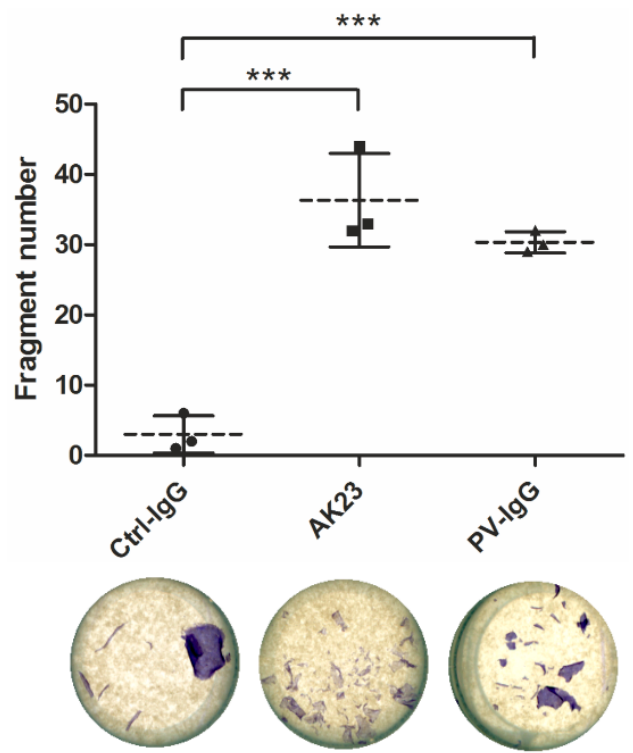
Figure 8. E ff ect of PV-IgG and anti-Dsg3 antibodies on the monolayer integrity in hTert cells. The cells were grown in KGM with 0.05 mM calcium until confluent and then shifted to 2 mM calcium for 24 h. Thereafter, the cells were treated with either purified control IgG, PV-IgG or AK23 antibody for further 24 h. Dispase was used to break the cell-matrix adhesion, and resulting monolayers were pipetted up and down to induce fragmentation. The resulting fragments were counted using ImageJ. Statistical analysis was done using ANOVA with Bonferroni’s multiple comparison test. Statistically significant di ff erences are indicated by *** p < 0.001. n = 3 independent experiments. Dotted line: Mean of samples, solid lines: SD.